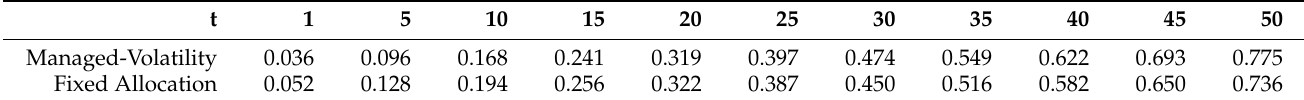
Table 7. Coefficient-of-Downside Deviation of Annuity Payments.